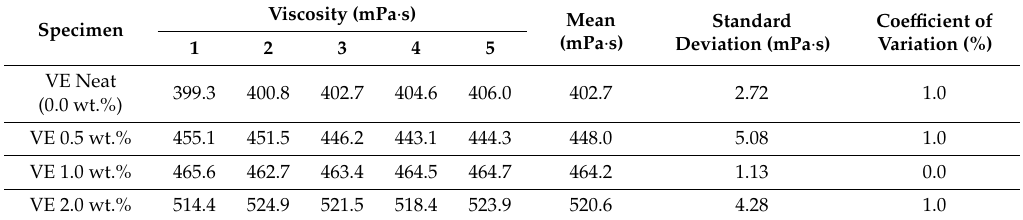
Viscosity (mPa · s) Mean